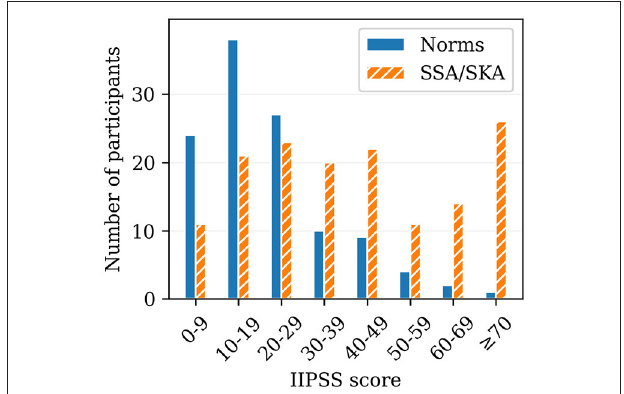
FIGURE 1 | Histogram indicating score distribution of the Iowa Interview for Partial Seizure-like Symptoms (IIPSS; Roberts, 1999) for the previously published “normal” population (Norms; N = 115; Roberts, 1999) and for the participants of this study (SSA/SKA; N = 148).